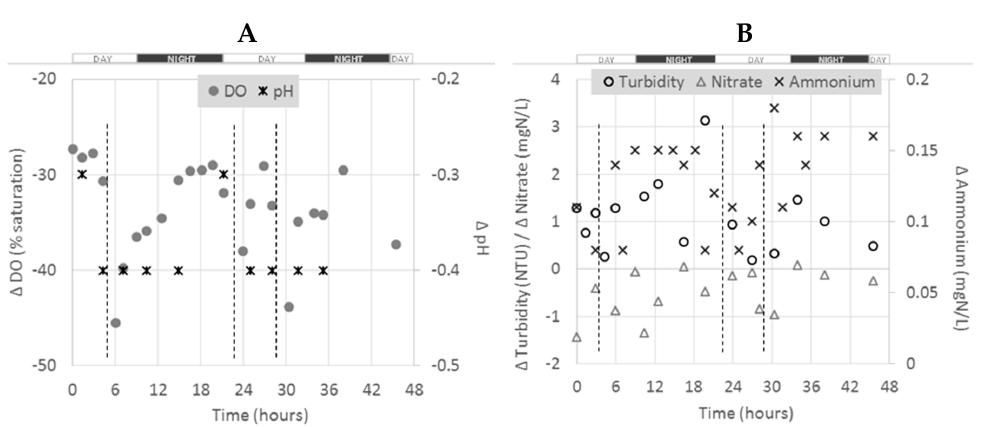
Figure 3. Pond 1 15 differential values between outlet and inlet for dissolved oxygen and pH ( A ) and for turbidity, nitrate and ammonium ( B ) during the monitoring program. Vertical dash lines represent feeding times.